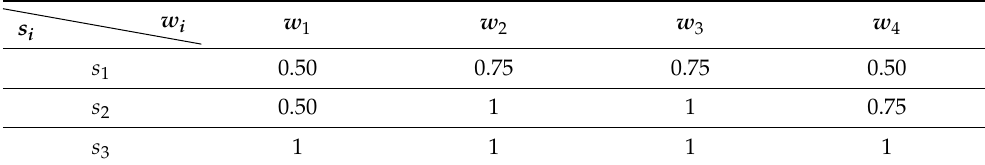
Table 2. Weight value assignment for RIFs based on the network state s t